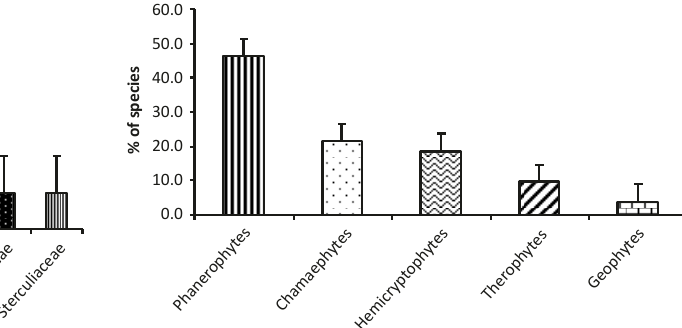
Figure 3. Life forms (biological spectrum) indicating a phanerophytic bioclimate.